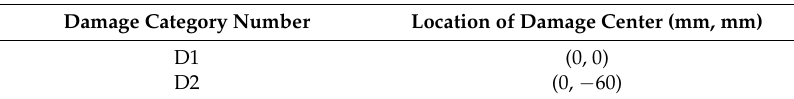
Figure 6. Impedance of the bonded PZT disk: ( a ) magnitude of the impedance; ( b ) phase angle of the impedance. Table 1. Locations of the damages.